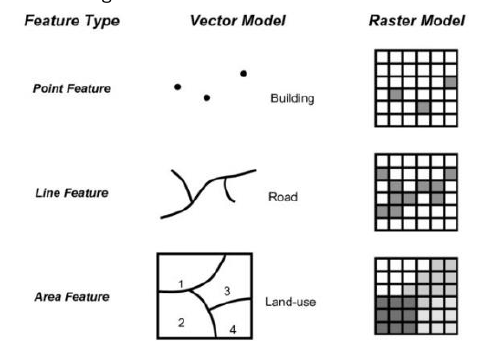
Figure 1. Illustration of vector and raster spatial data type (Zhu,